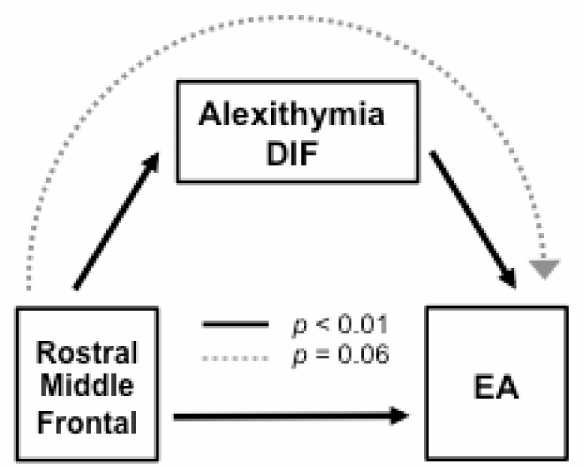
Figure 3. Path analysis showing cortical brain associations with alexithymia Difficulty Identifying Feelings (DIF) and emotional availability (EA) in the whole sample. The model shows the direct effects of the right rostral middle frontal gyrus (RMFG) on alexithymia DIF, and on the emotional availability (EA) exhibited in the mother-child interactive play task. The indirect effect through alexithymia DIF was marginal, but the total effect of RMFG thickness on EA remained